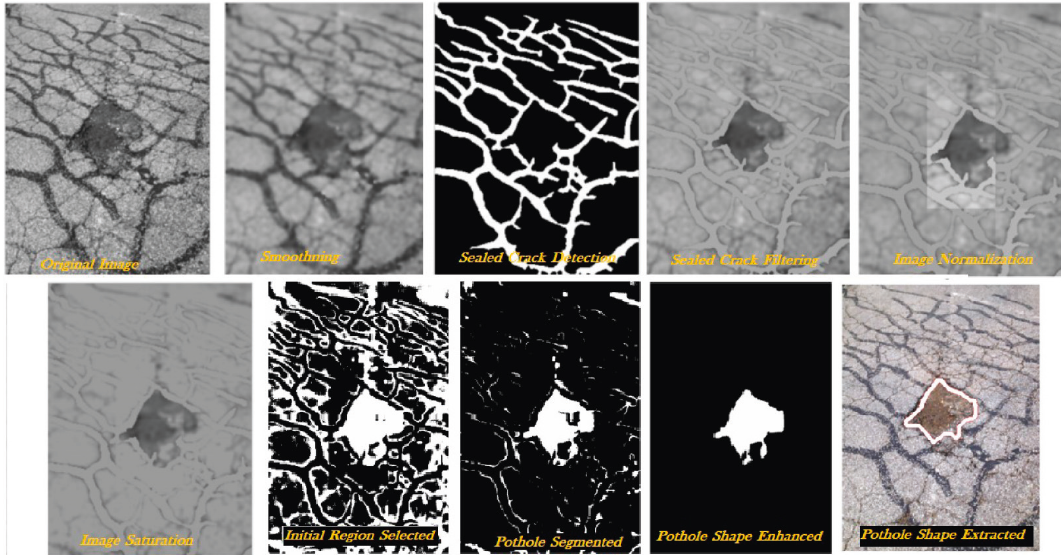
Figure 4: Example of pothole extraction by 2D image pre- and postprocessing [62].